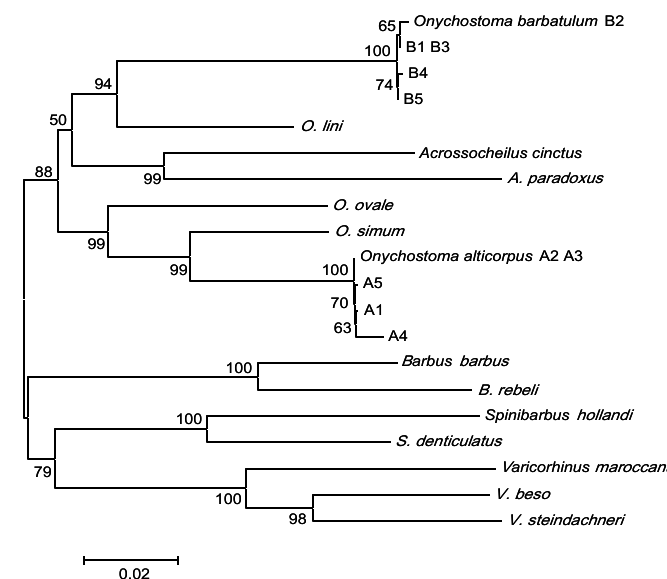
Figure 6. The neighbor-joining evolutionary tree reconstructed based on Cyt b gene sequences from five Onychostoma barbatulum (B1–B5) and five O. alticorpus (A1–A5) from Taiwan and 12 reference sequences from NCBI GenBank (with accession numbers): Acrossocheilus cinctus (JX066772), A. paradoxus (HQ443699), Onychostoma lini (JQ343982), O. ovale (JX074246), O. simum (HM536801), Barbaus barbus (KC465927), B. rebeli (AF090791), Spinibarbus hollandi (NC026129), S. denticulatus (NC021616), Varicorhinus maroccanus (AF287457), V. beso (JQ716388), and V. steindachneri (AF180865). The scale bar indicates the nucleotide diversity between sequences. The bootstrapping value of each branch is shown in front of the node. Table 1. Nucleotide numbers, interspecific and intraspecific Kimura-2-parameter genetic distances (gray area) estimated from 10 cytochrome b gene sequences and four reference sequences. Values of genetic distances are decimals, while different nucleotide numbers are integers. Specimens A1–A5 are Onychostoma alticorpus and B1–B5 are O . barbatulum. Reference sequences from NCBI GenBank (with accession numbers) included Osi, O. simum (HM536801); Oov, O. ovale (JX074246); Vma, Varicorhinus maroccanus (AF287457); Vbe, V. beso (JQ716388).